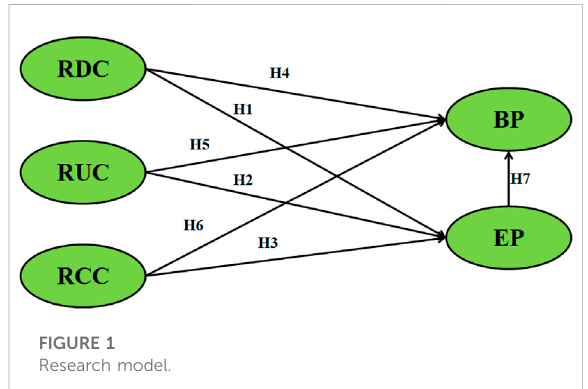
FIGURE 1 Research model.